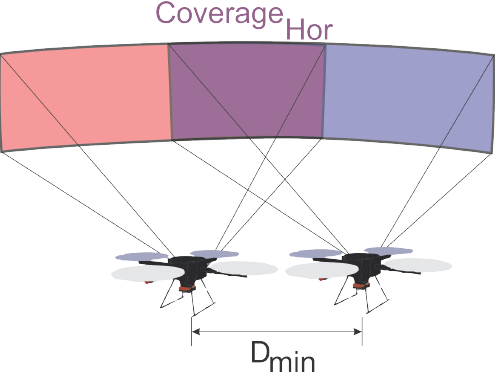
Figure 4. Horizontal coverage.